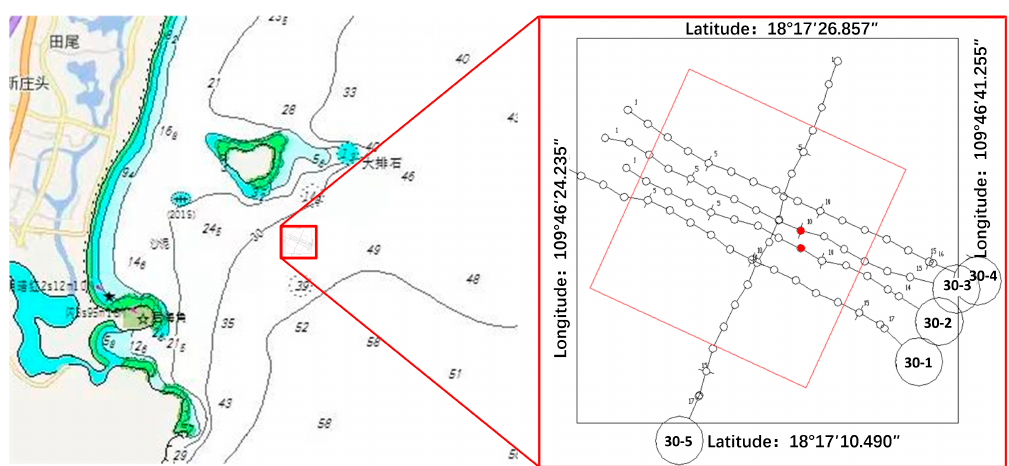
Figure 18. Track line in the Sanya Sea area.